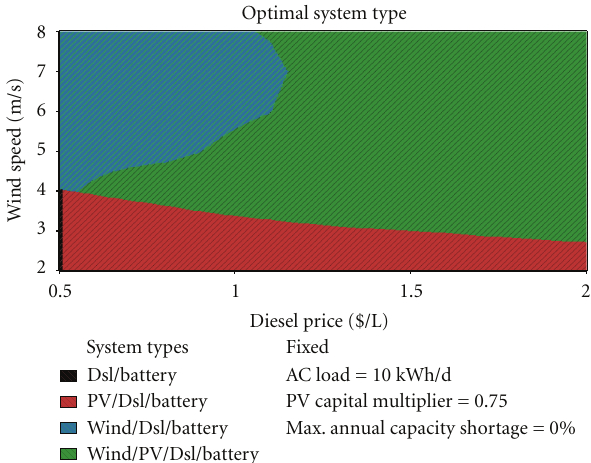
Figure 6: Results for the optimization space of the complete system of Figure 5, disconnected from the grid.